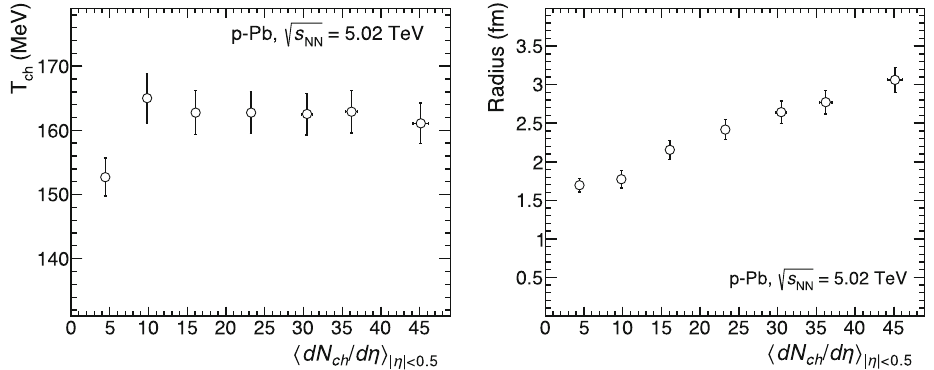
Fig. 6 The temperature (left pane) and the radius (right pane) at chemical freeze-out as a function of charged particle multiplicity (cid:7) dN ch / d η (cid:8) | η | < 0 .